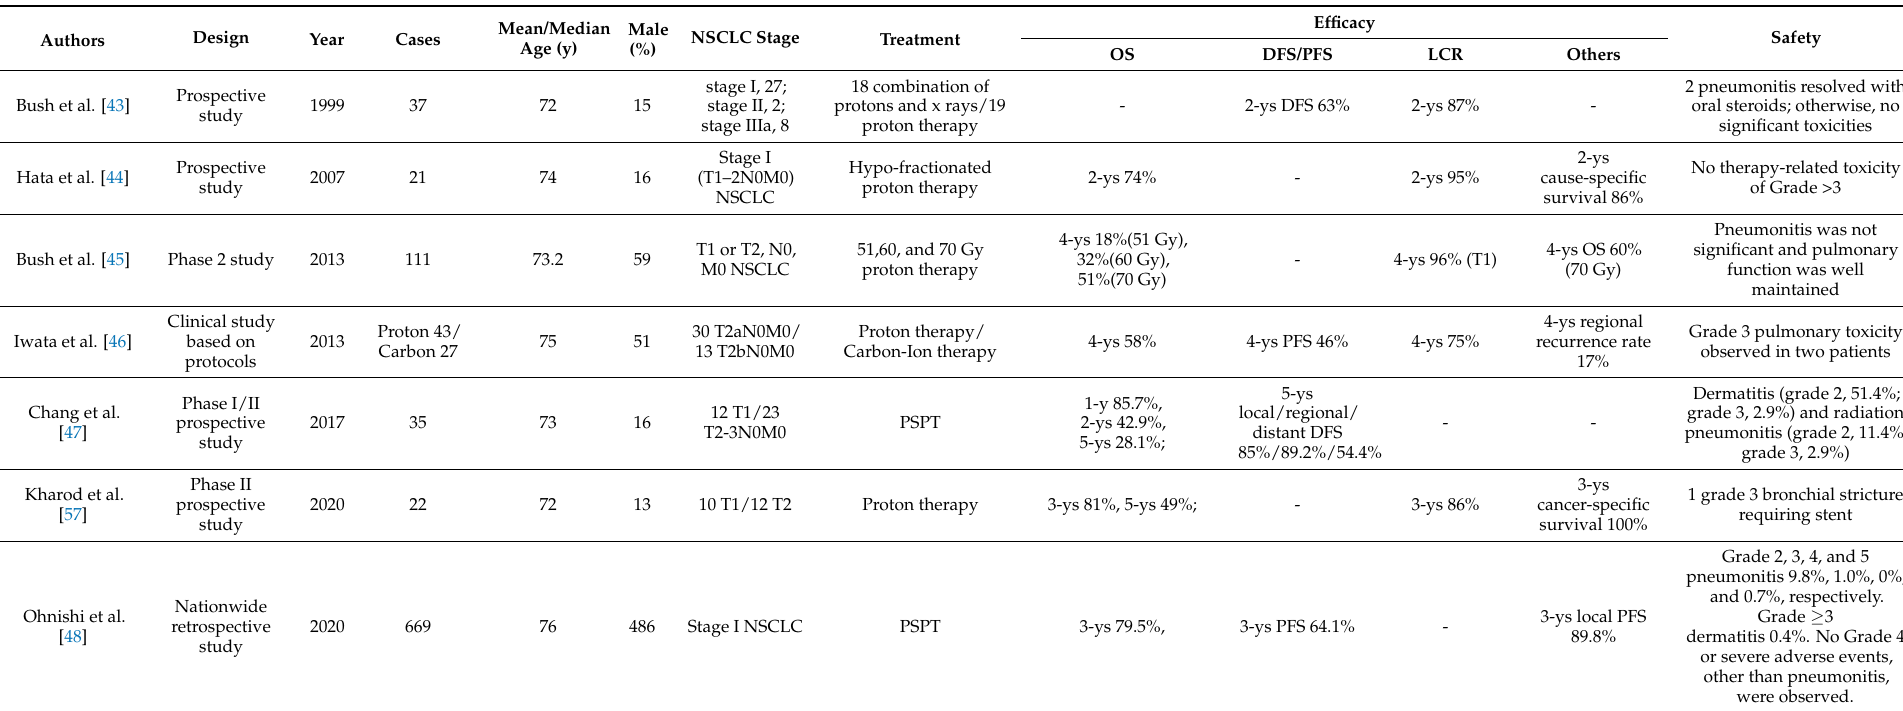
Table 2. Published prospective study/nationwide retrospective study involving proton therapy for early-stage